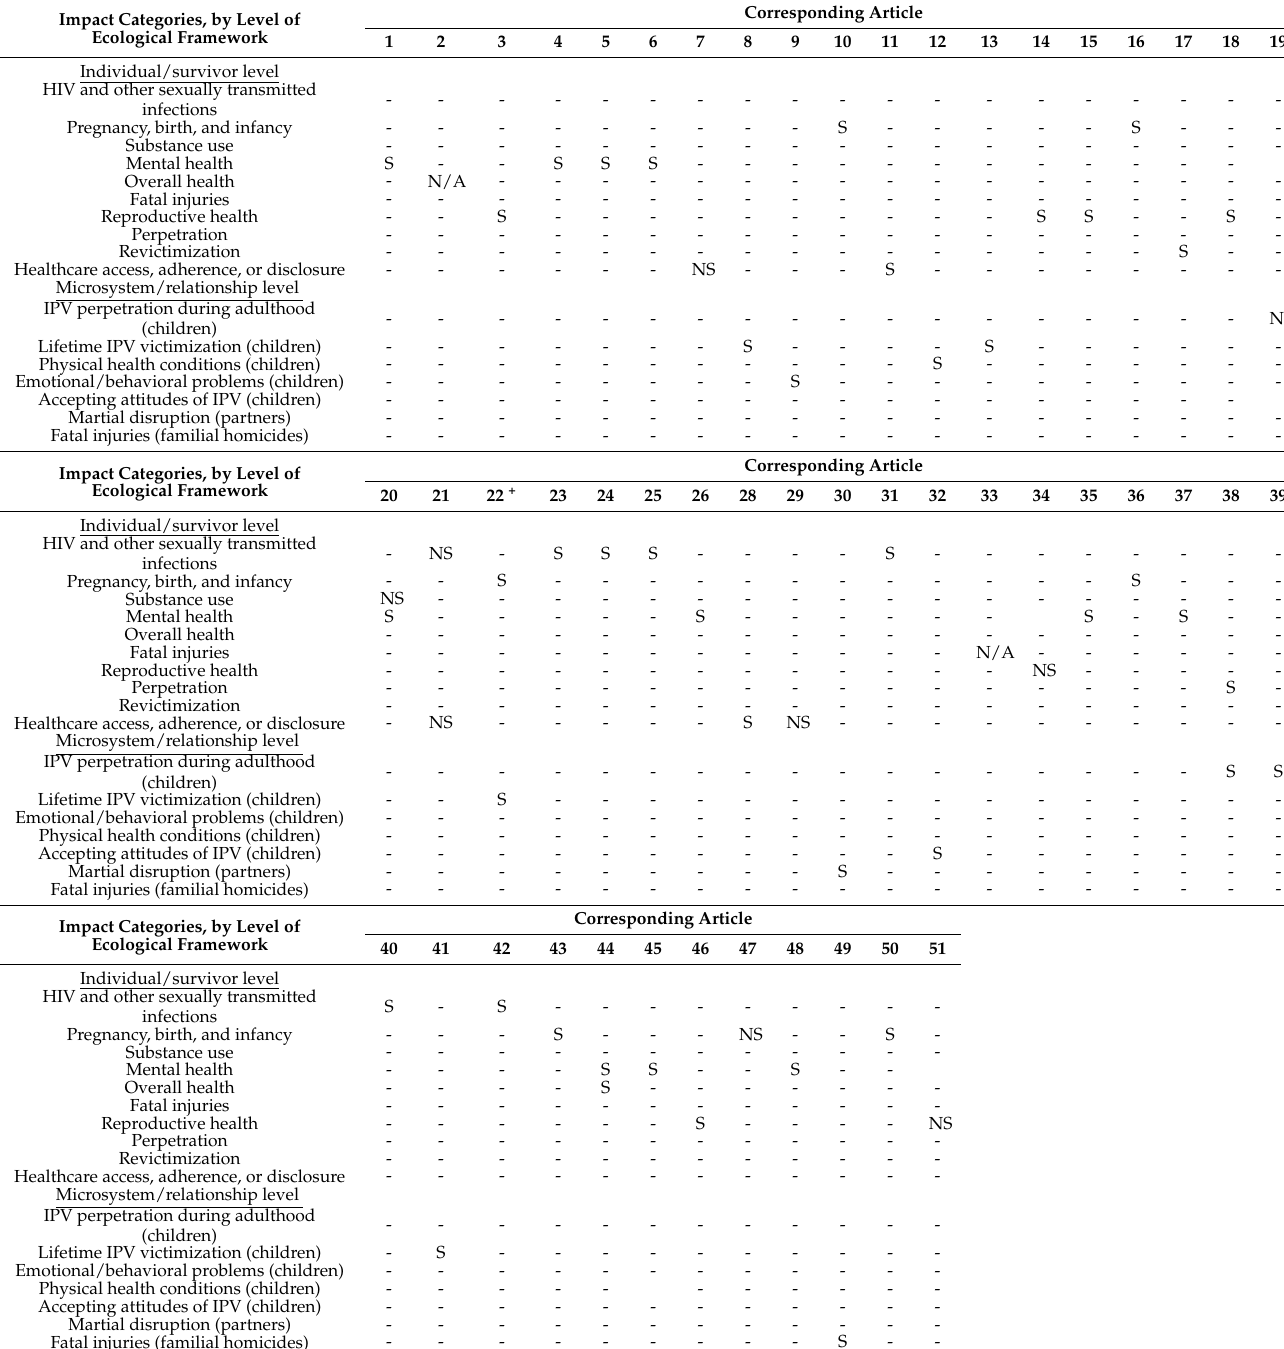
Table 2. Associations with intimate partner violence, per